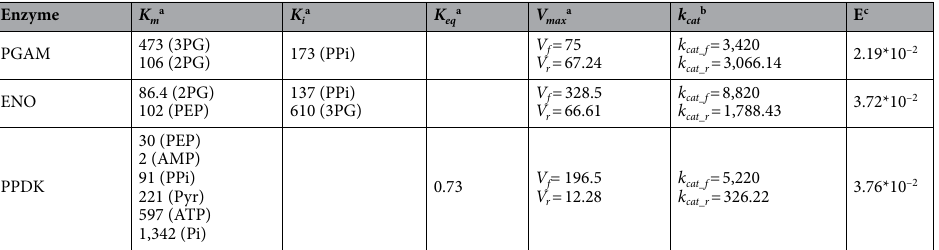
Table 1. Kinetic parameters of the enzymes in the second part of the glycolysis. Michaelis constants ( K m ) and inhibitor constants ( K i ) are in µM, maximum rates of the forward and reverse reactions ( V f and V r ) in mU, enzyme amounts (E) in nmol and k cat of the forward and reverse reactions ( k cat_f and k cat_r ) in min −1 . K eq is the equilibrium constant of the reaction. a Data taken from a previous study 8 and V r were calculated from enzyme proportions 7 . b Data taken from a previous study 6 and k cat_r were calculated from V r and E. c E were calculated V f from V f and k cat_f by using the equation: E = k cat _ f